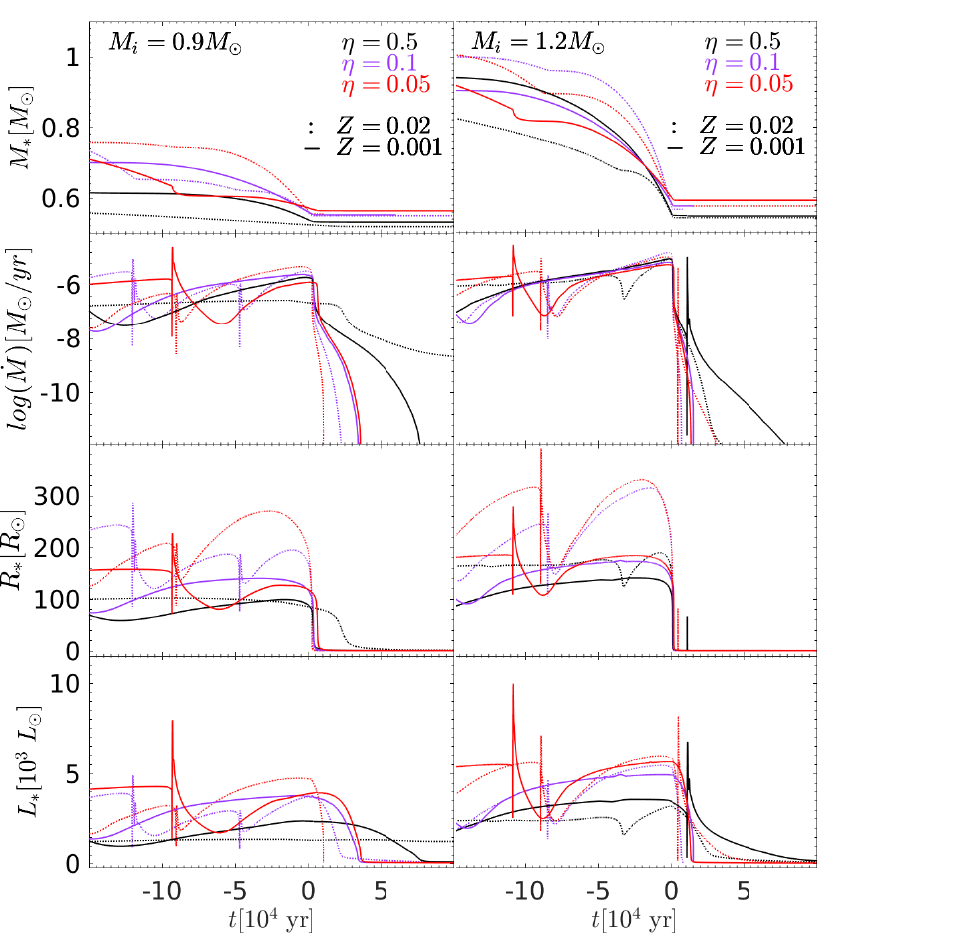
Figure 1. The evolution during the final (cid:39) 2.5 × 10 5 yr of the asymptotic giant branch (AGB) of stars of initial mass 0.9 M (cid:12) ( left plot ) and 1.2 M (cid:12) ( right plot ). The graphs are shifted so that at t = 0 the envelope mass of the star is equal to 0.01 M (cid:12) . We present the evolution for 2 metallicities: Z = 0.02 (solar; dotted) and Z = 0.001 (old population; solid), and for three mass-loss rate efficiency parameters, η = 0.5 (the “traditional” commonly mass-loss rate efficiency; black), η = 0.1 (purple), and η = 0.05 (red). The panels depict, from top to bottom: the mass of the star, the mass loss rate (logarithmic of the absolute value), the stellar radius, and the stellar